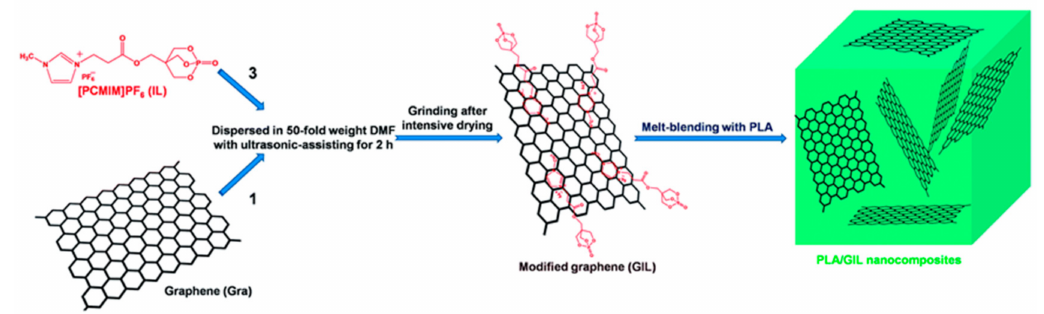
Figure 3. Surface functionalization of graphene using an ionic liquid (Adapted with permission from